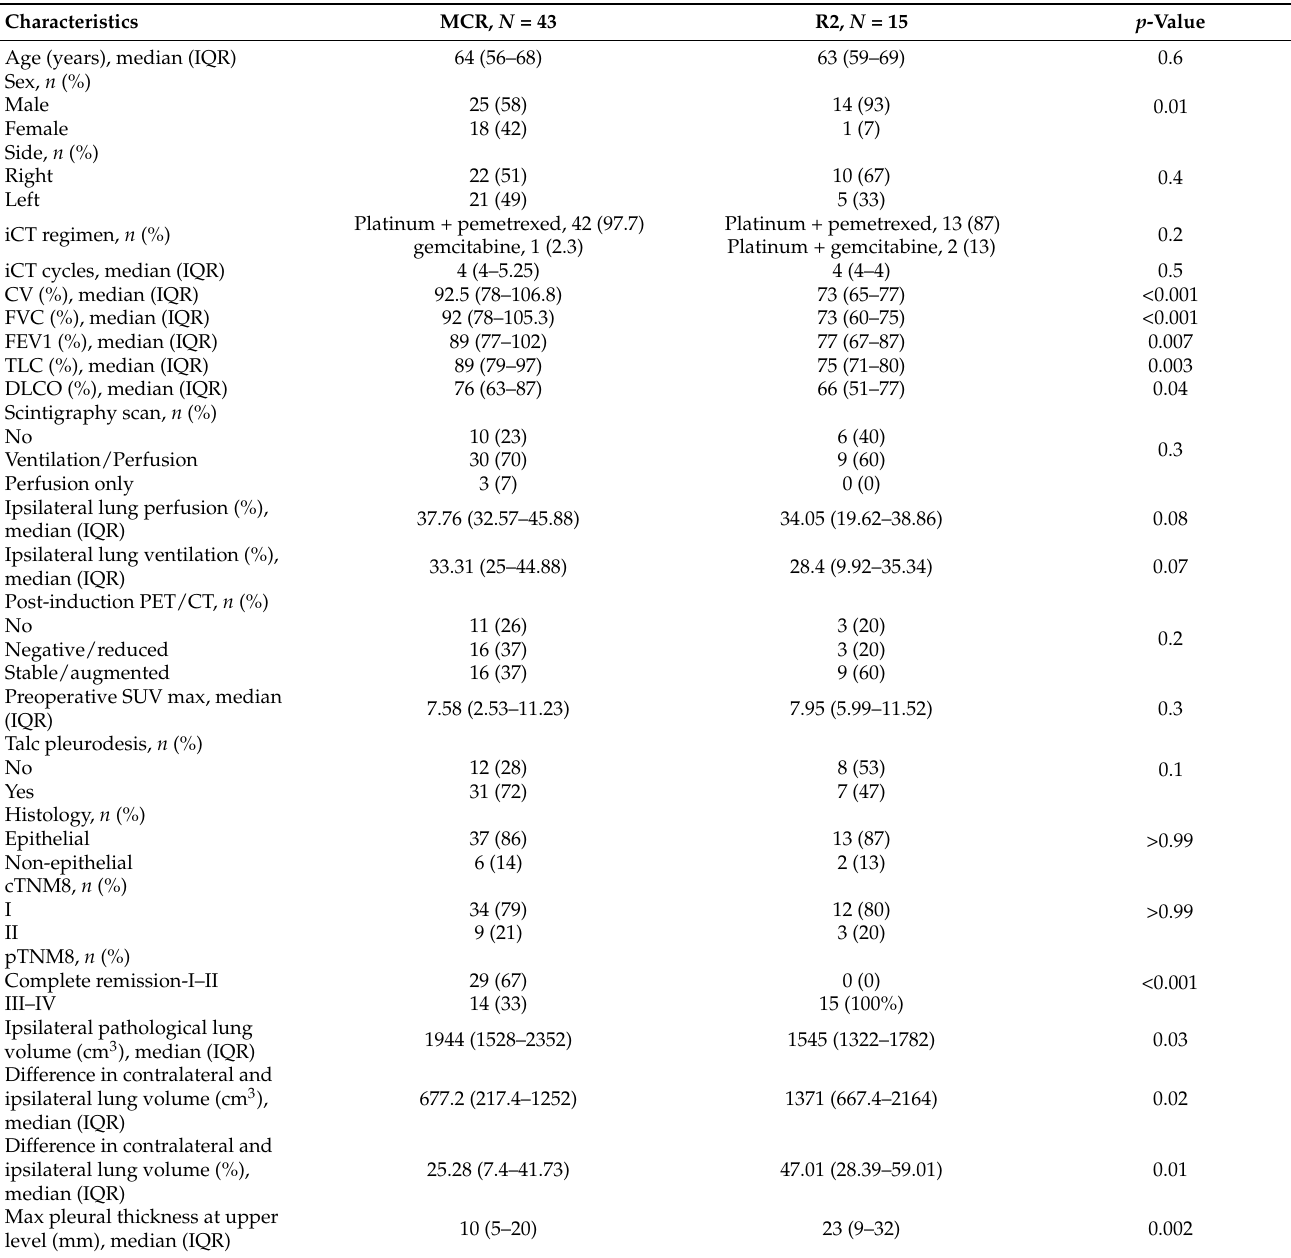
Table 1. Patient